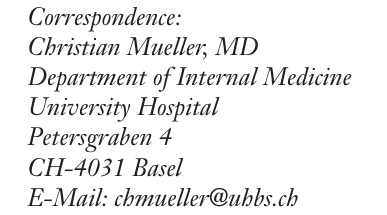
Minimal lumen diam- eter at the lesion at baseline (pre), imme- diately after the inter- vention (post), and at 6 months follow-up in the IVUS and ANGIO